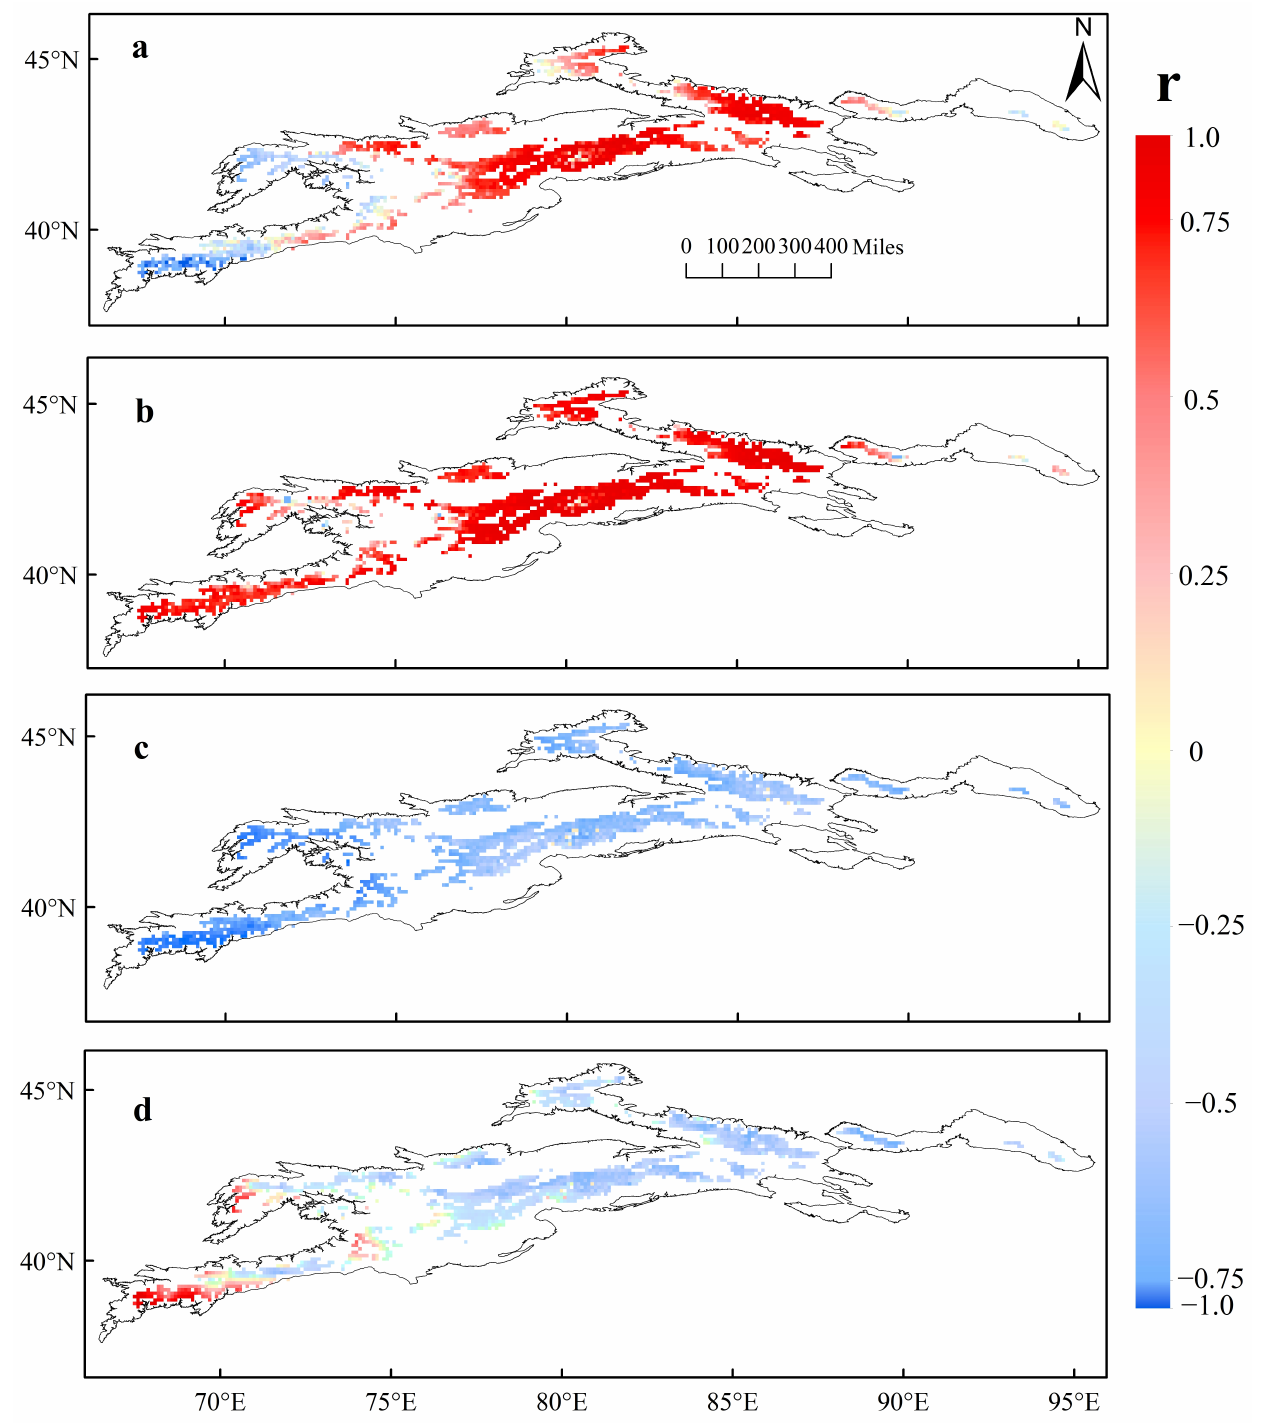
Figure 5. Spatial correlations between the mass balance change and temperature in the accumulation period ( a ), precipitation in the accumulation period ( b ), temperature in the ablation period ( c ), and precipitation in the ablation period ( d